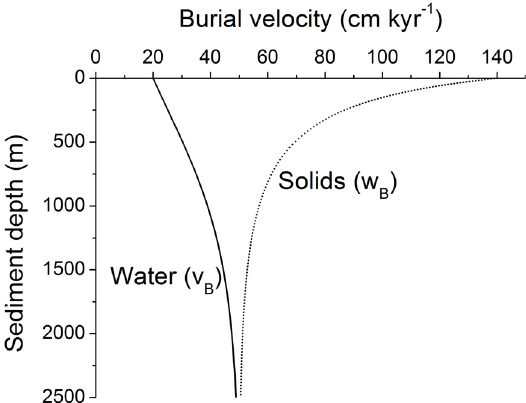
) and solids ( w ) in marine sediments subject to B B = 50 cm kyr − 1 f